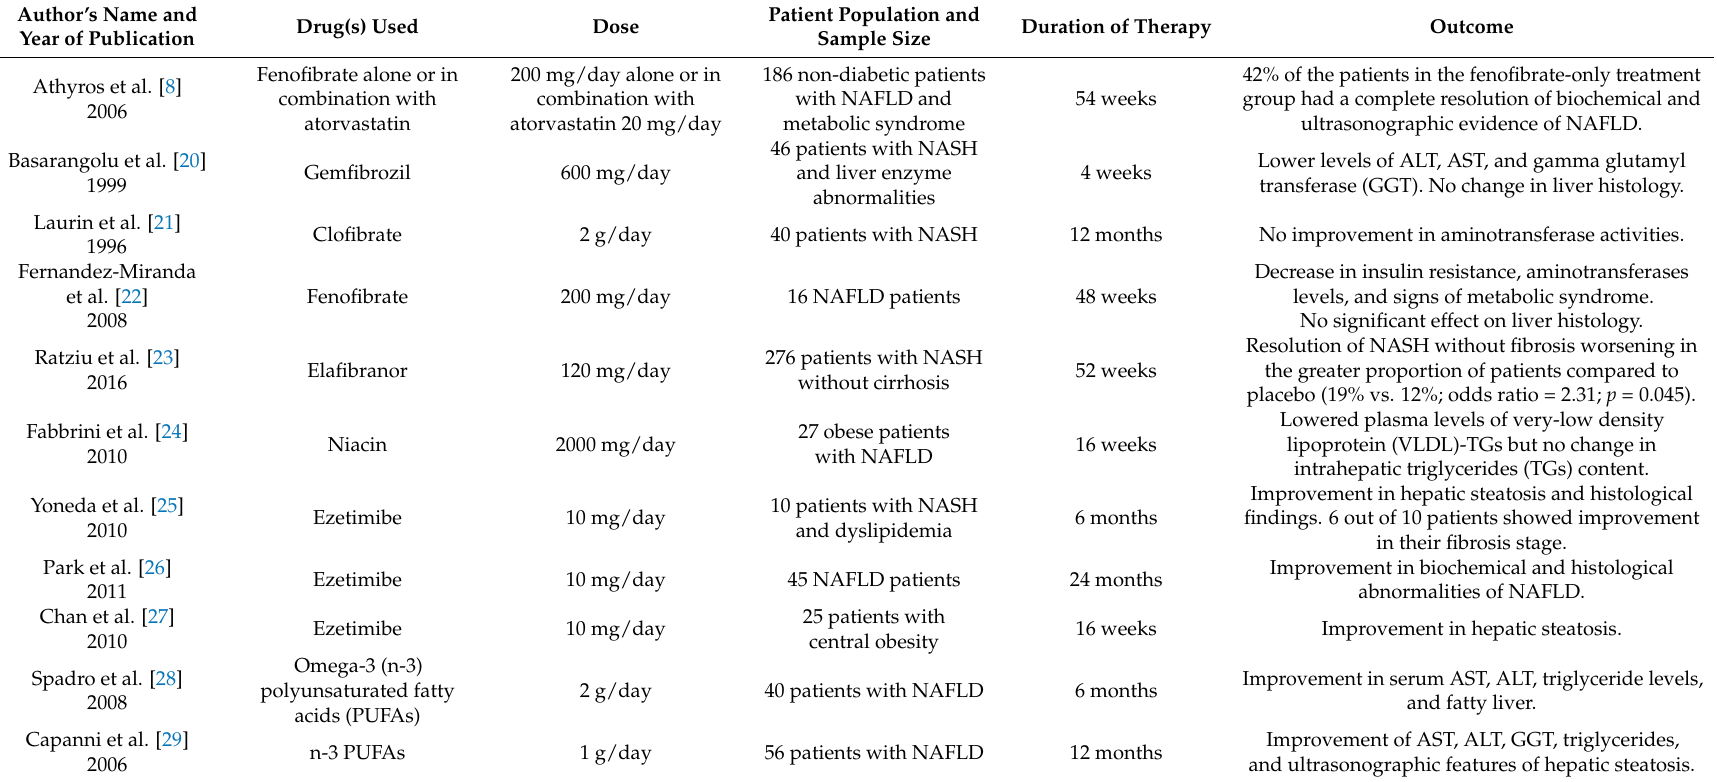
Table 2. Studies evaluating the utility of lipid-lowering drugs in